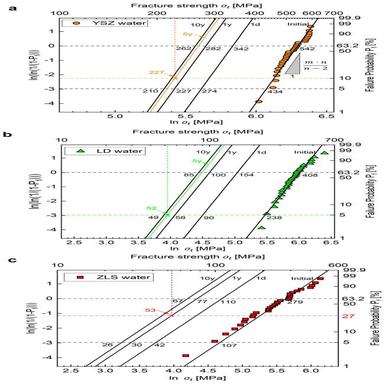
SPT diagrams of YSZ (a), LD (b) and ZLS (c) for 1 day, 1 year and 10 years under simulated static loading conditions.